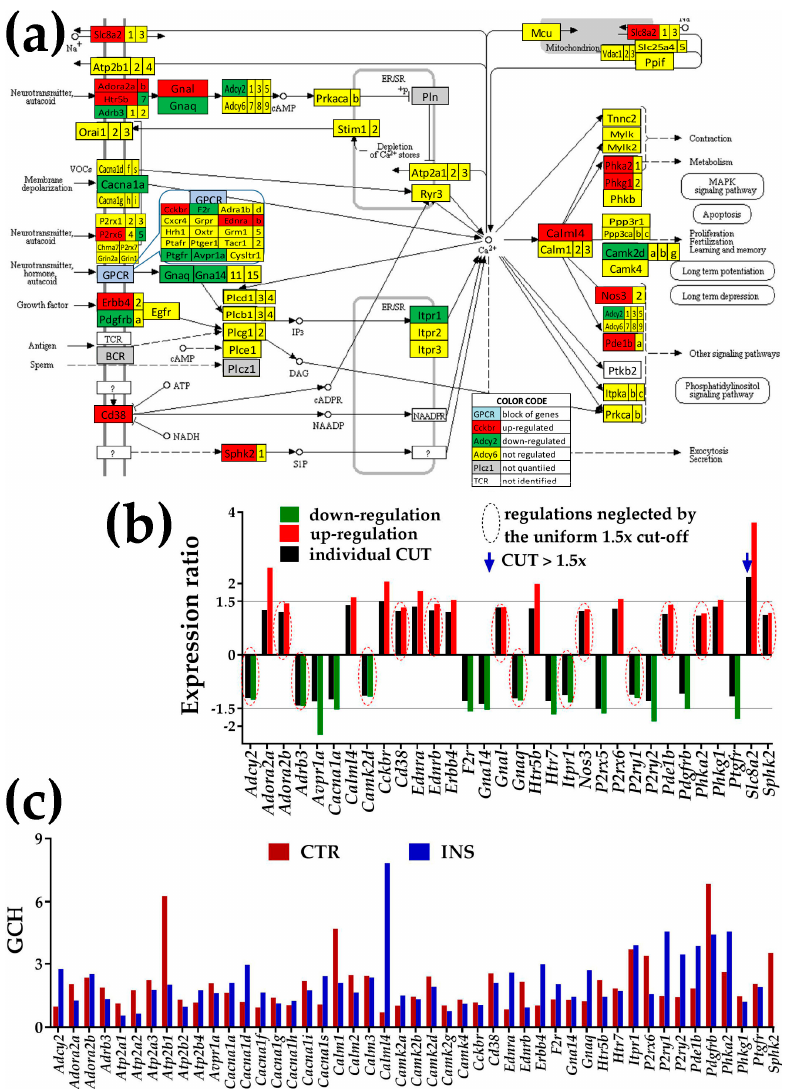
Figure 4. Presence of non-touching Oli-neu cells regulates calcium signaling (CAS) pathway in astrocytes (modified from mmu04020, www.kegg.jp). (a) Regulation of interconnected genes within